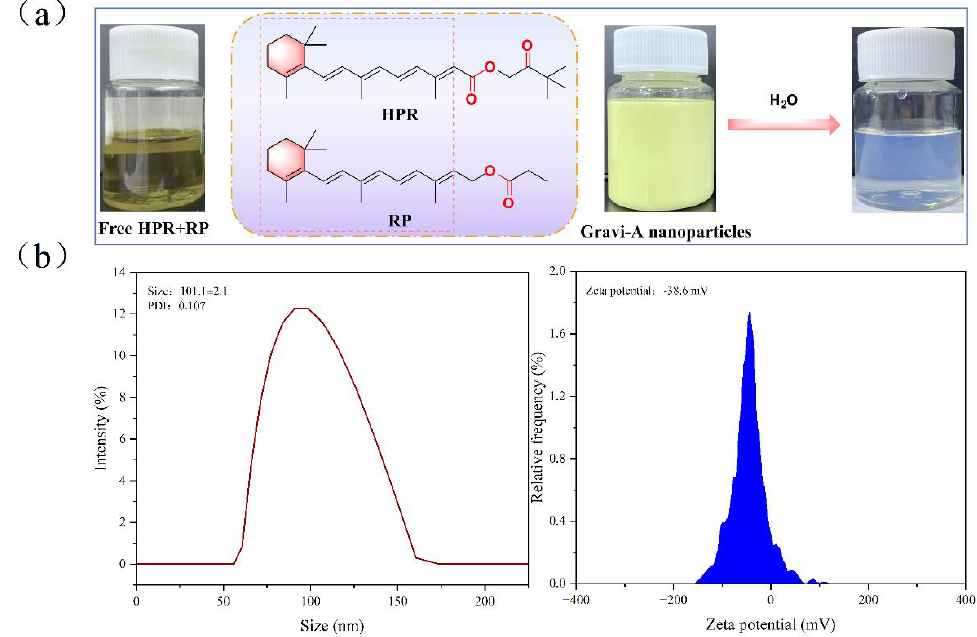
Figure 1. ( a ) Free HPR + RP and supramolecular Gravi − A nanoparticles, where PDI represents polymer dispersion index. ( b ) Particle size and zeta potential of supramolecular Gravi − A nanoparticles using DLS.